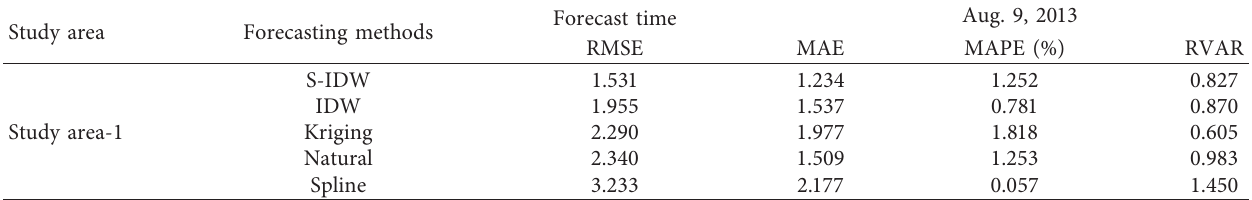
Table 10: Comparison of interpolation accuracy of 5 kinds of interpolation methods on Aug. 9, 2013. Study area